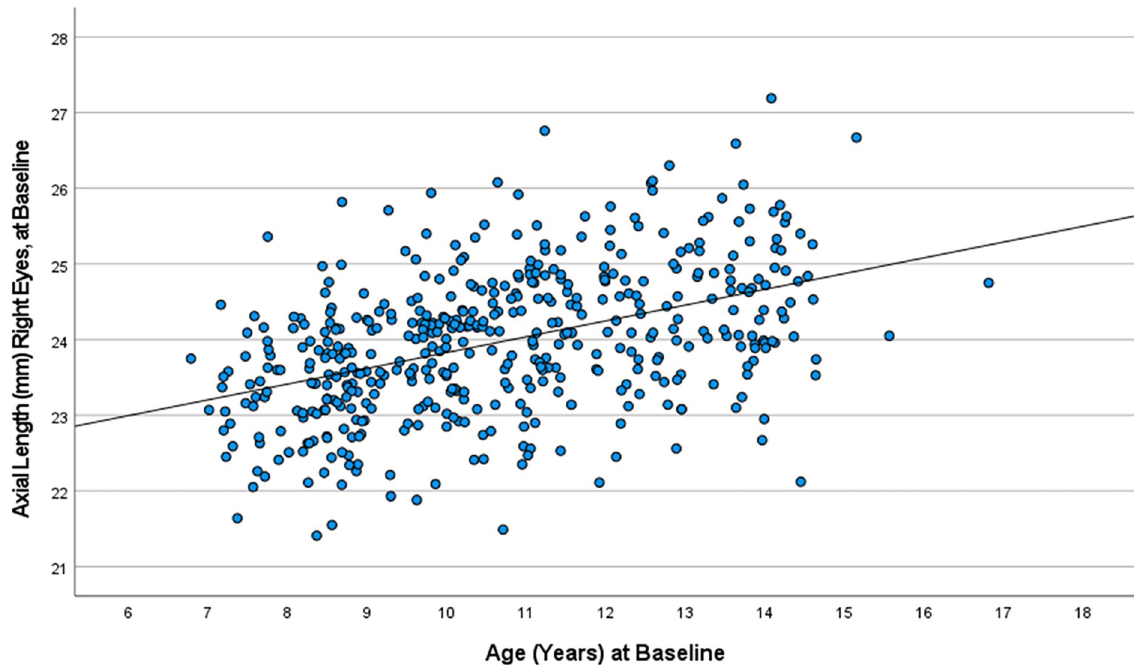
Fig 1. Scattergram showing the distribution of axial length in the right eyes before start of the COVID-19 lockdown, stratified by age in the Ural Children Eye Study. Equation of the regression line: Axial Length (mm) = 21.74 mm + 0.21 (95%CI: 0.17, 0.25) x Age